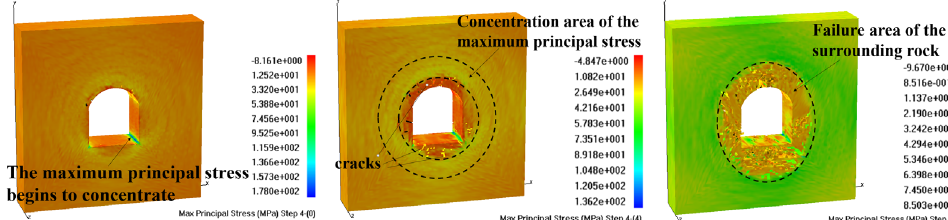
Figure 4. Distribution of the maximum principal stress.